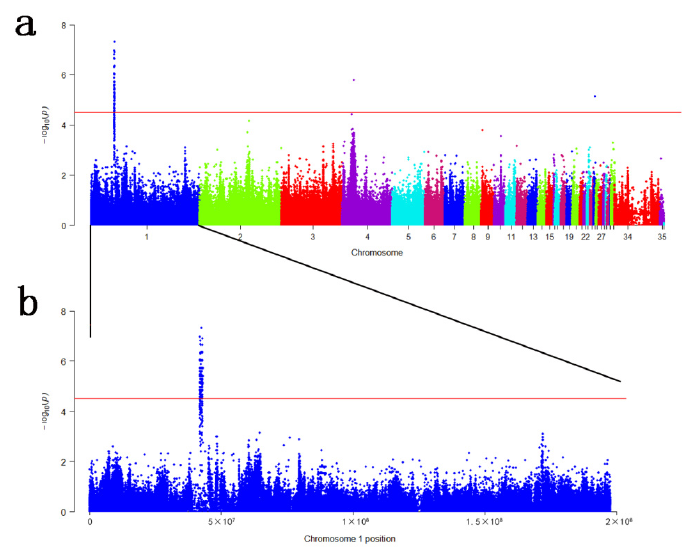
Figure 2. Manhattan plots of GWAS for RIR stripe pattern. ( a ) Manhattan plot of all association bi-allelic variants (SNPs and INDELs) with the RIR stripe pattern; ( b ) Manhattan plot of GGA1 asso- ciation bi-allelic variants (SNPs and INDELs) with the RIR stripe pattern. Manhattan plots indicate -log10( p ) for variants (y-axis) against their positions on each chromosome (x-axis). Chromosomes 34 and 35 indicate Chromosome Z and W, respectively. The solid red line represents the genome-wide significant threshold ( p = 3.07 × 10 − 5 ). Table 2. A descriptive summary of significant variants associated with the RIR stripe pattern in GWAS.